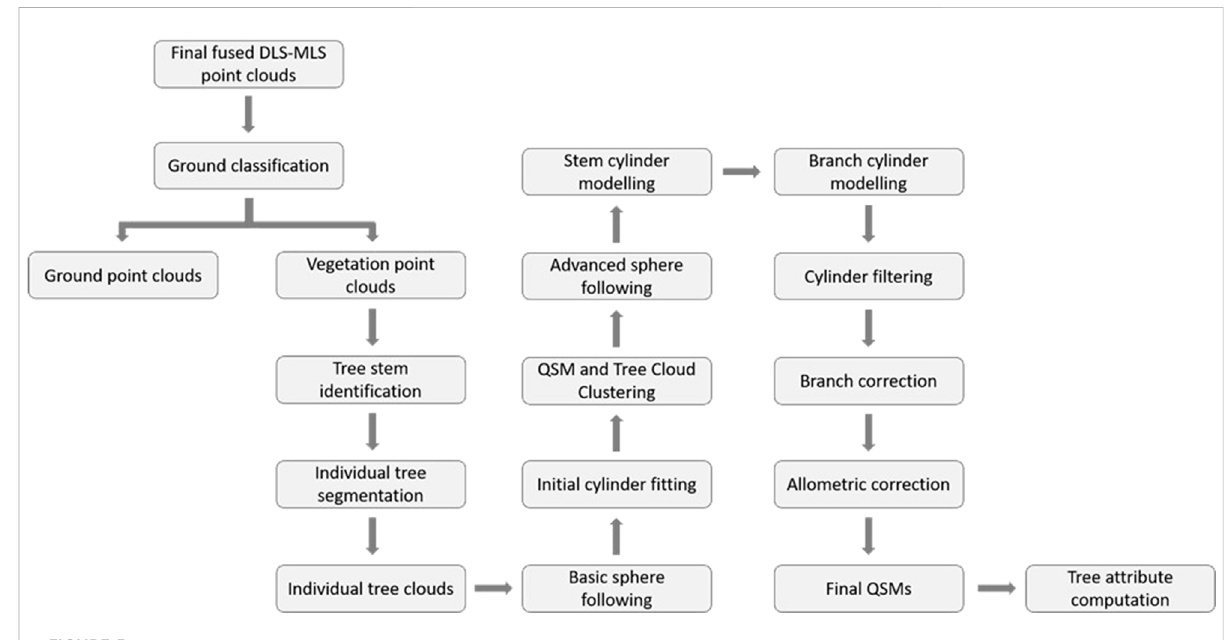
FIGURE 5 The key processing steps of vegetation point clouds separation, individual tree segmentation, and QSM